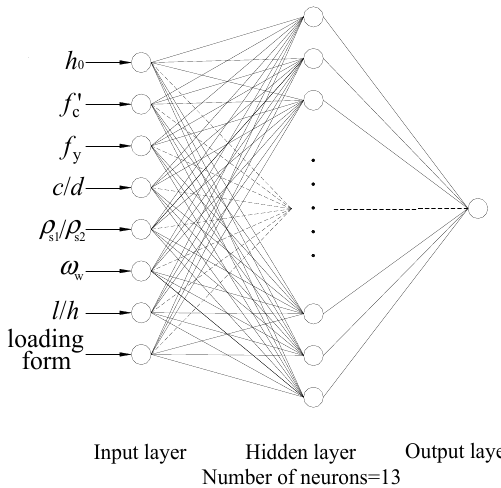
Figure 10. Final network configuration used in present study.